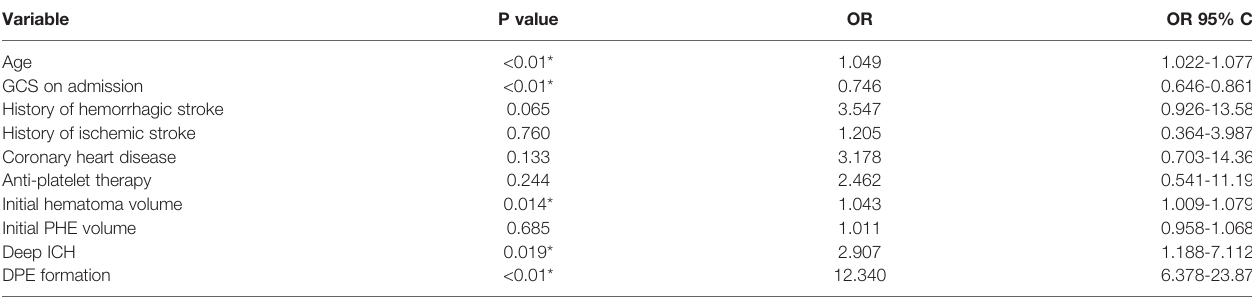
GCS, Glasgow coma scale; PHE, Perihematomal edema; ICH, Intracerebral hemorrhage; DPE, Delayed perihematomal edema expansion; *Indicates P value <0.05. DPE formation indicates DPE 1st (>3.34 mL) or DPE 2nd (>3.78 mL).